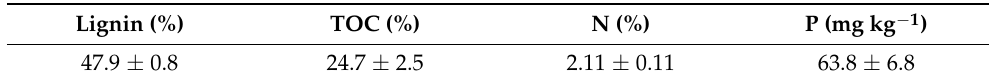
Table 2. Lignin and nutrient contents from the standard litter material used in the litter decomposition assay (mean ± standard deviation, N = 25).